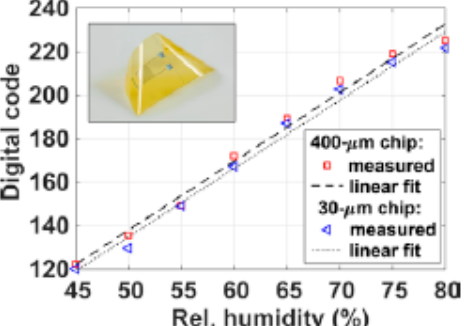
Figure 3. Measured 8-bit ADC output for bulk and ultra-thin readout chips while varying RH and under constant temperature. Inset: 5 × 5 mm 2 on-foil RH